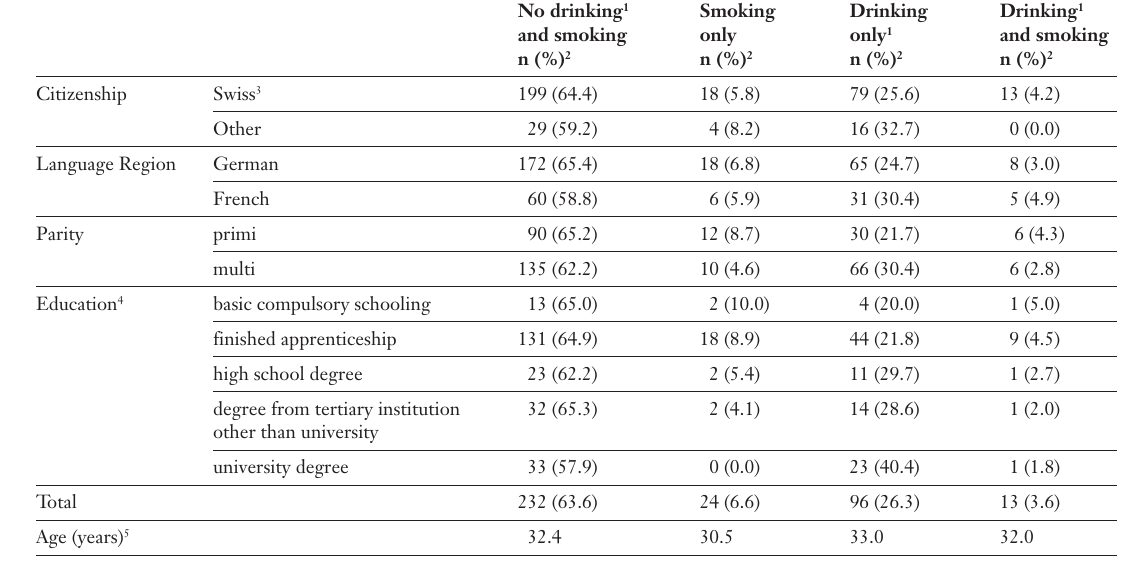
Table 1 Sample characteris- tics by the level of prenatal substance